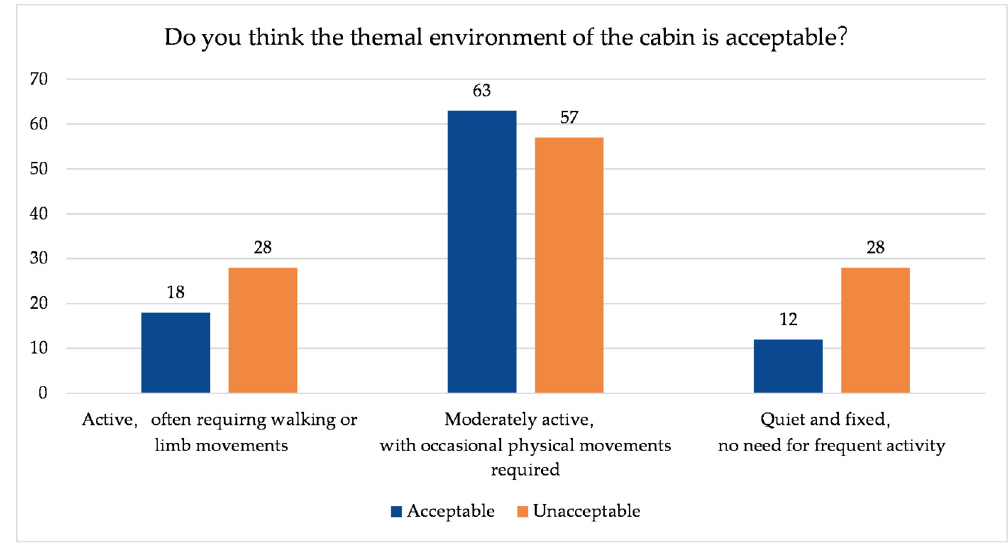
Figure 9. Questionnaire for activities and thermal tolerance.